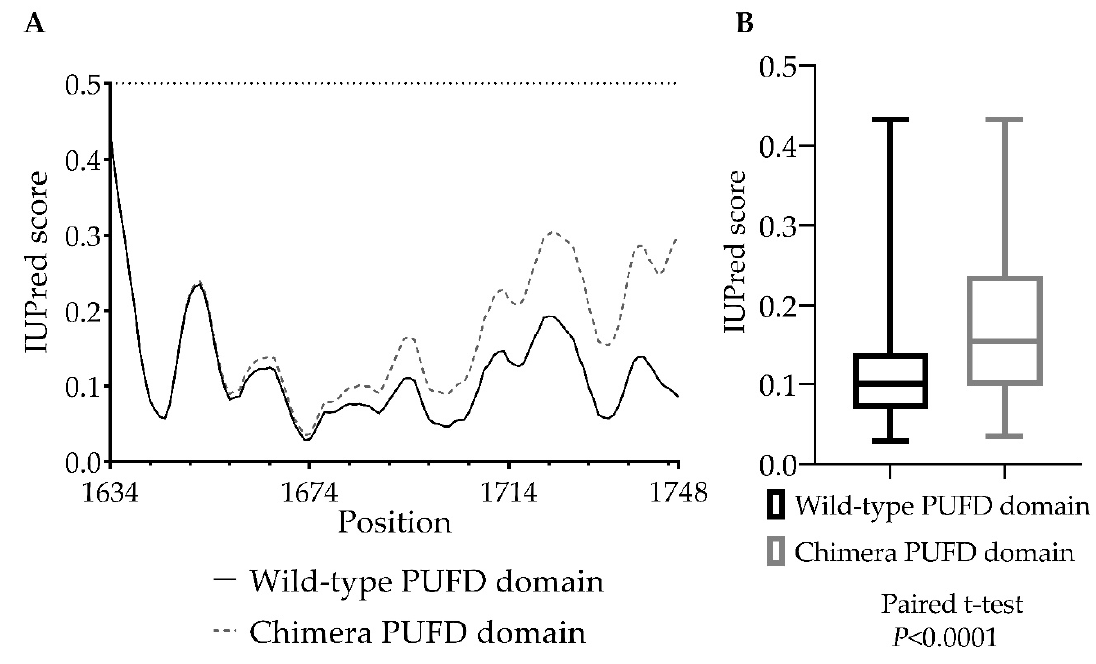
Figure 4. The PUFD domain’s IUPred3 long disorder analysis of wild-type BCOR and the chimera protein. ( A ): IUPred3 scores of the PUFD domain on the graph, where a score of 0 means a completely ordered protein structure and a score of 0.5 and above means a disordered protein structure. ( B ): Statistical comparison of the PUFD domain IUPred3 scores between BCOR and the chimera protein (between 1634 and 1748 residues). A significant increase was measured in the IUPred3 scores of the chimera PUFD domain, which means that the domain is more disordered compared to the wild-type domain, where p < 0.0001. Error bars indicate the minimum/maximum of the values obtained from the analysis of two different sequences.